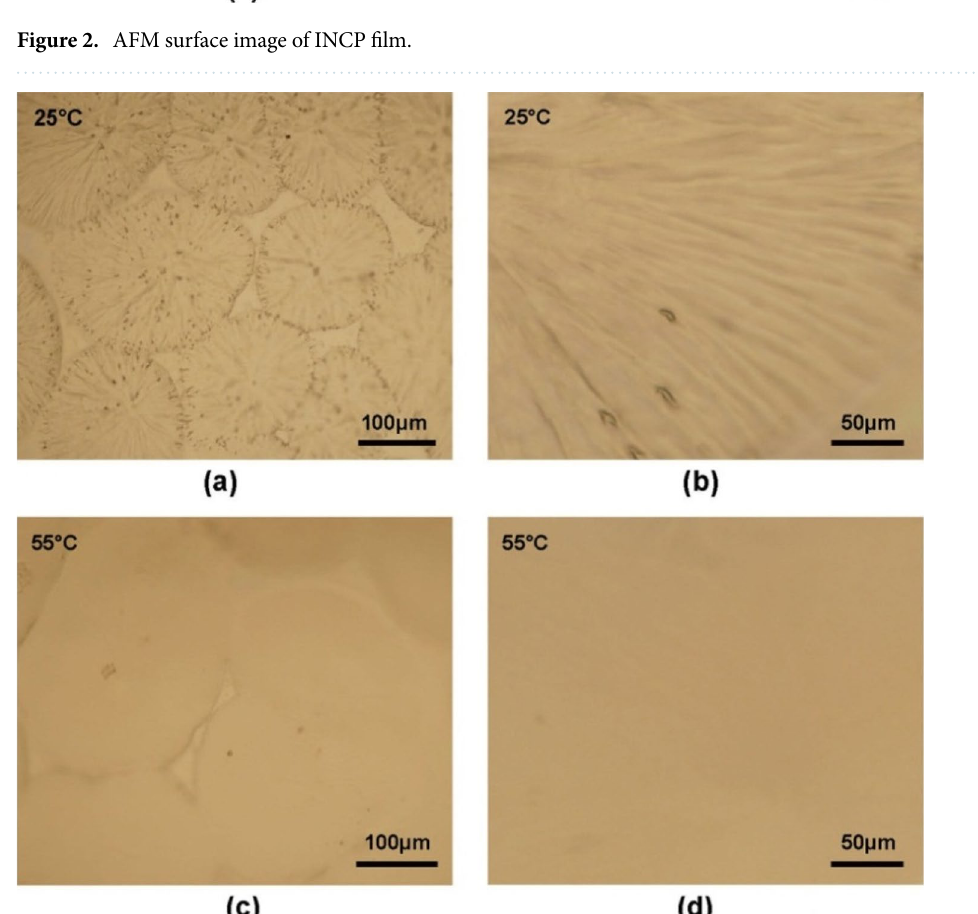
Figure 3. Bright field optical microscopy images of INCP film at 25 and 55 °C ( a – d